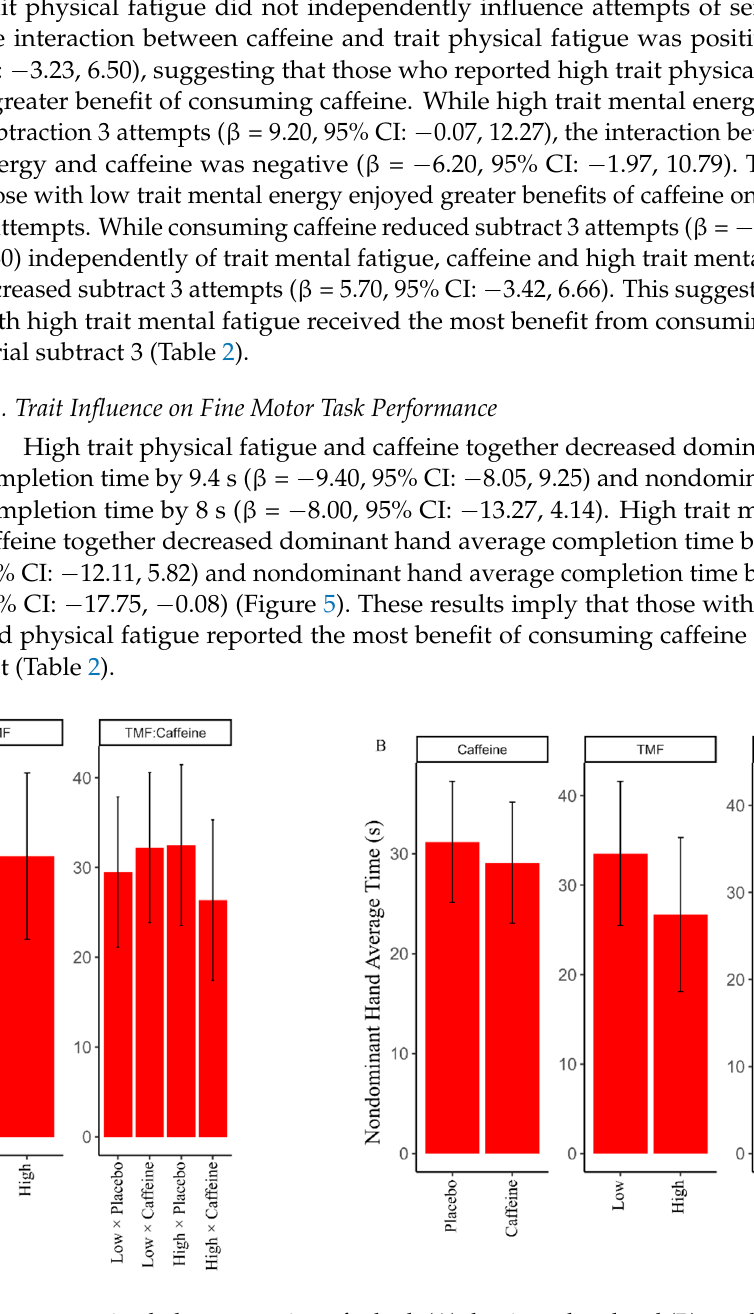
Figure 5. Trait and caffeine influence on nine-hole peg test times for both ( A ) dominant hand and ( B ) nondominant hand average times. TMF = Trait Mental Fatigue.